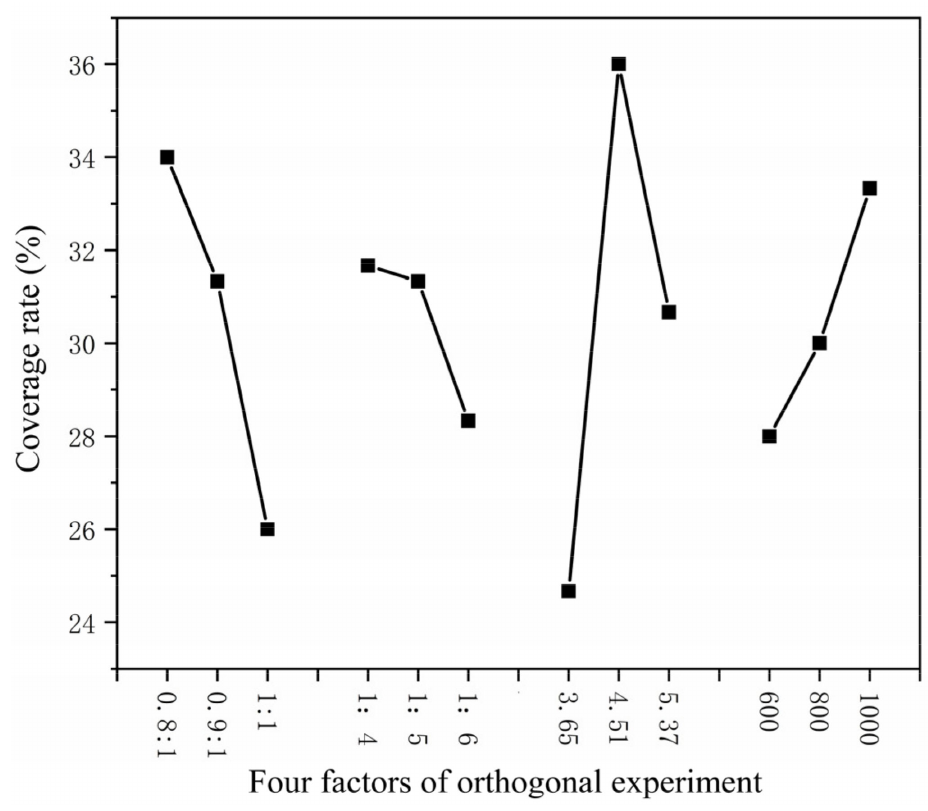
Figure 2. Relationship between four factors of orthogonal experiment coverage